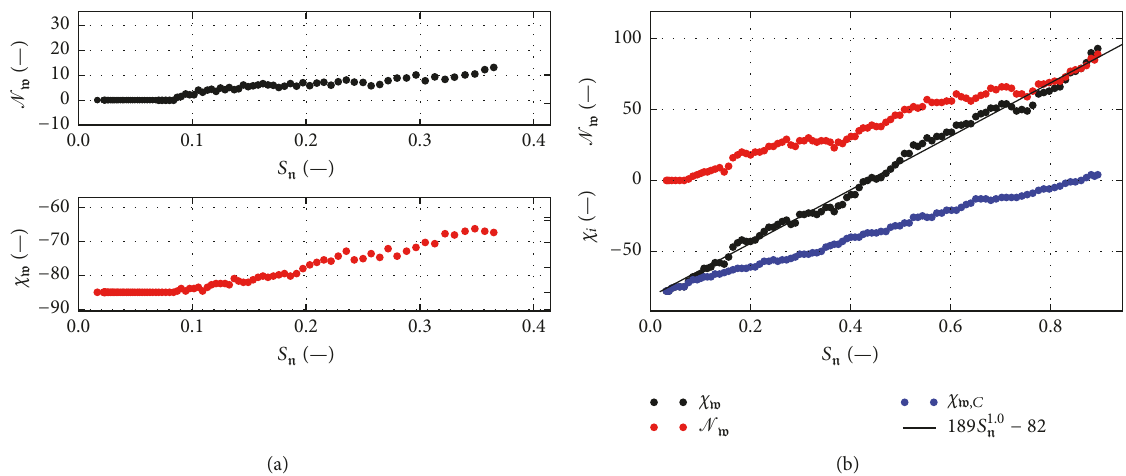
Figure 8: (a) Number of isolated components ( N w ) and Euler characteristic ( 𝜒 w ) of WP for viscous fingering at log 10 ( Ca , 𝑀) = (−2,−1) in microstructure B. (b) Euler characteristics of WP and reservoir-connected WP ( 𝜒 w ,𝐶 ) as well as number of isolated components for stable displacement at log 10 ( Ca ,𝑀) = (−2,1) in microstructure